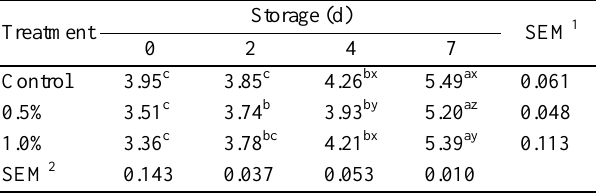
Table 5. Number of total aerobic bacteria (log CFU/g) in the thigh meat from the broilers fed combination of gallic and linoleic acid